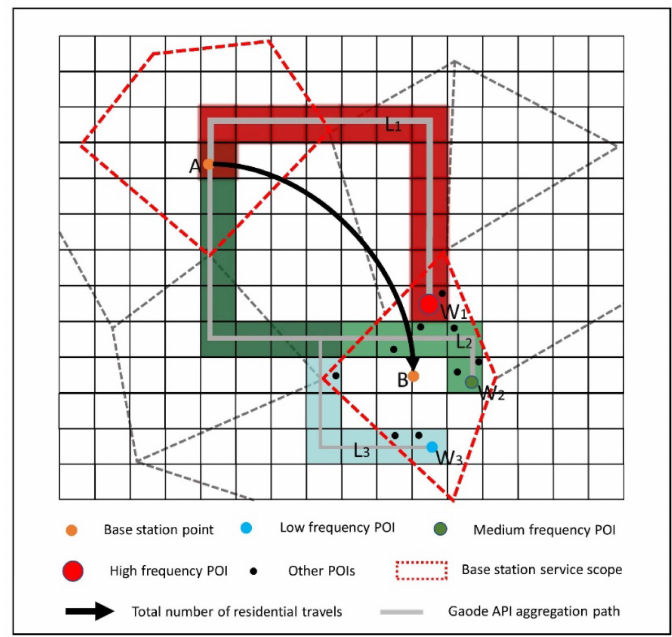
Figure 3. Frequency statistics